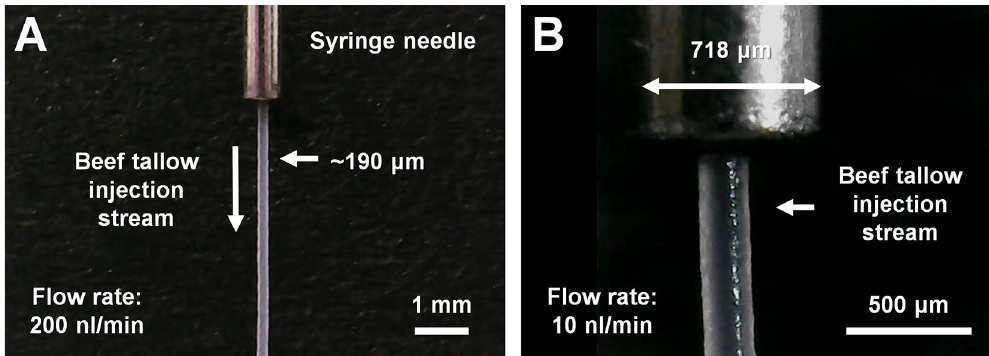
Figure 1. Beef tallow injection stream with embedded lysozyme crystals at flow rates of ( A ) 200 nL/min and ( B ) 10 nL/min. The inner diameters of the syringe needle and the injection stream of the beef tallow were 168 and < 200 μm,